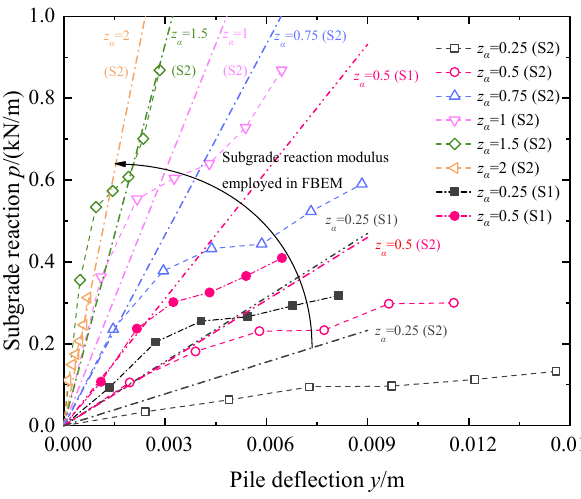
Figure 11. Comparisons of subgrade reaction modulus.